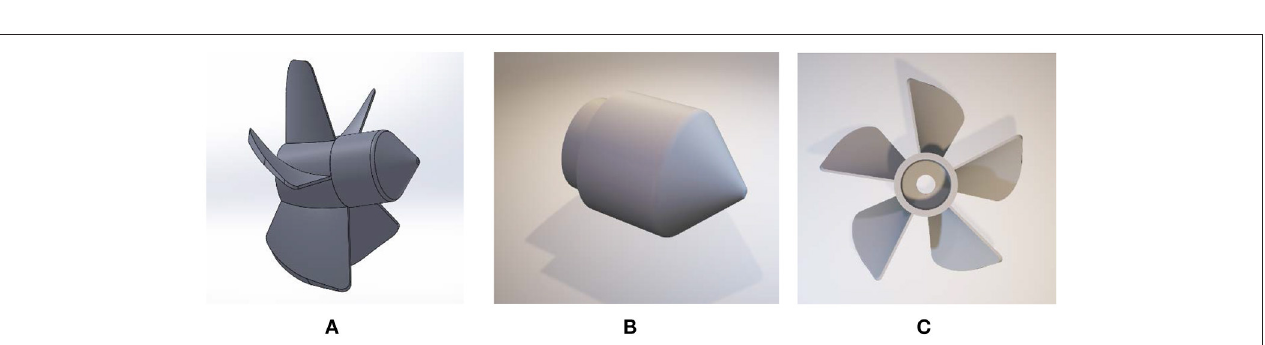
Figure 3 . The cylindrical magnet was rotated at servo motor. The magnetic field was measured with an HMR2300 magnetometer placed radially from the rotating magnet at a distance of 7.62 m. Figure 4A shows a raw periodogram spectral estimate with a small, but distinct, frequency feature at 2